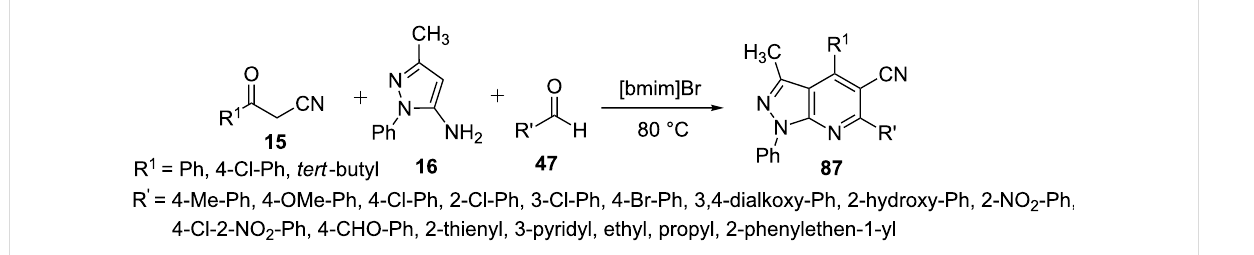
Scheme 23: Ionic liquid-mediated synthesis of pyrazolo[3,4- b